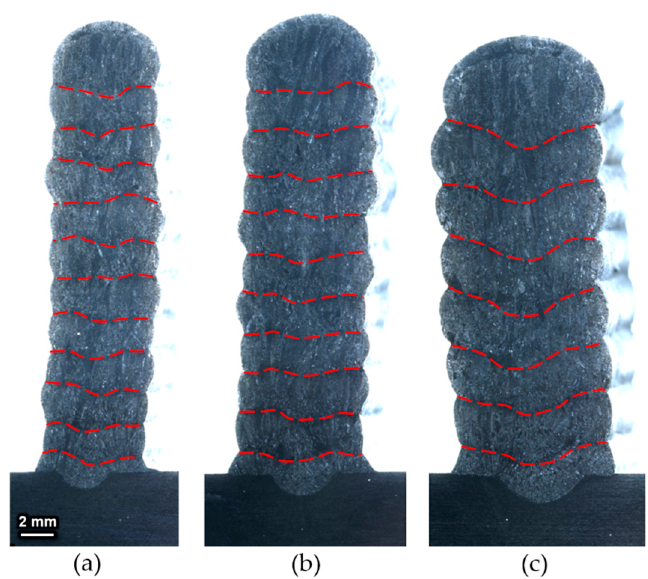
Figure 3. Macrosections of additively manufactured walls: ( a ) 0.40 kJ / mm, ( b ) 0.54 kJ / mm and ( c ) 0.87 kJ / mm. The dashed red lines indicate boundaries between deposited layers.